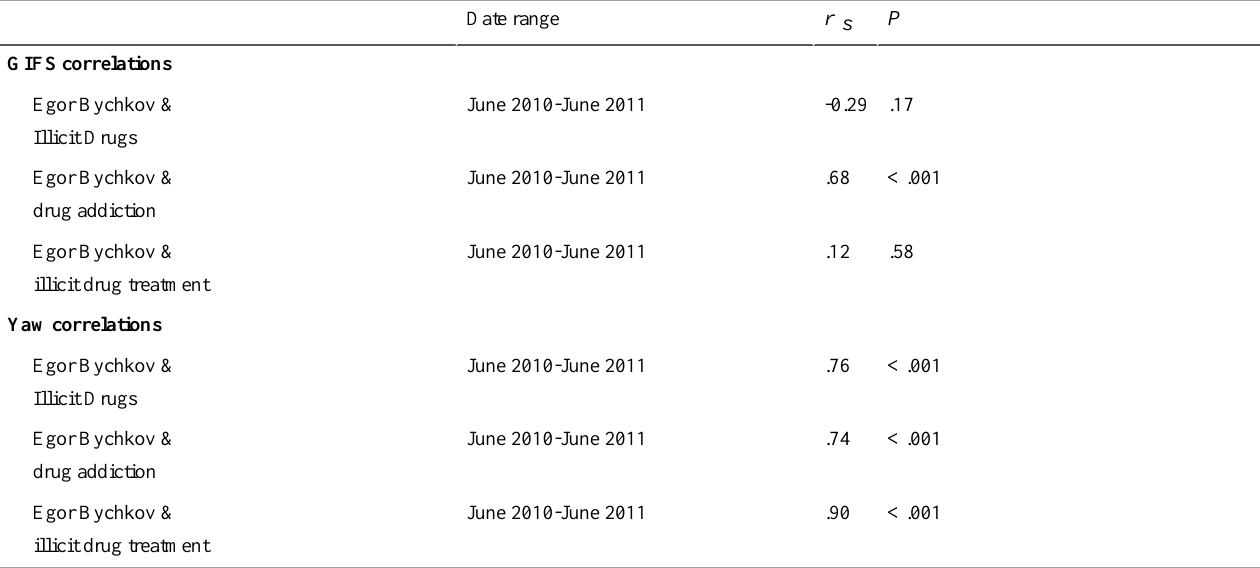
Table 6. Relationship between Bychkov episode and substantive drug policy